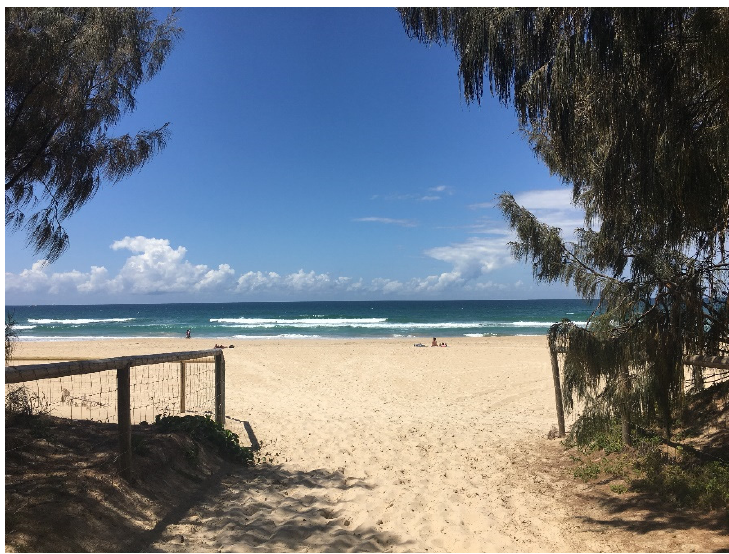
Figure 4. Building social glue: beach as a space to hang out with friends and family.